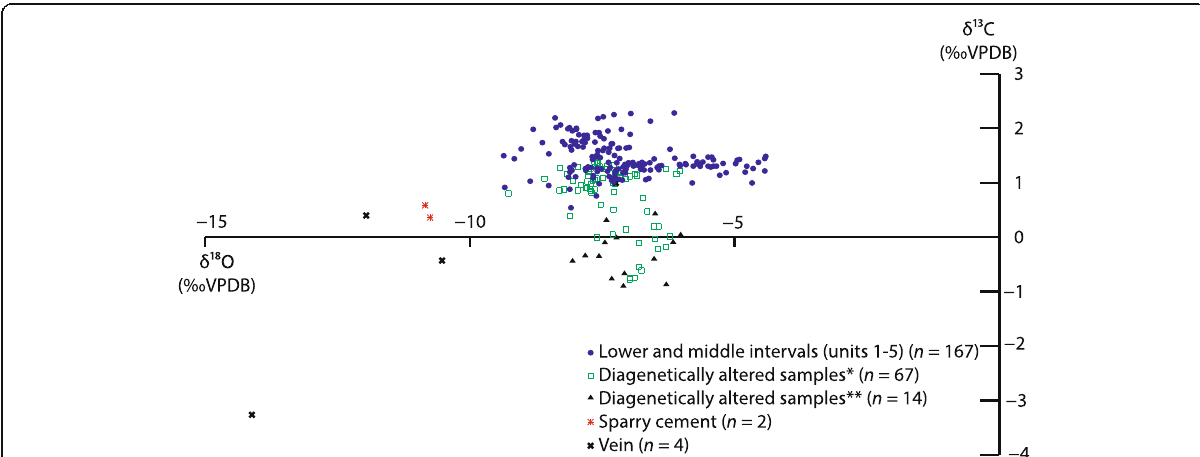
Fig. 7 Cross-plots displaying the relationship between δ 13 C and δ 18 O values of the studied bulk carbonate samples. Vein samples are from 1.14 – 1.20, 3.29 – 3.33, 120.39 – 120.43, and 148.68 – 148.72 mdfrh in core no. 4. Cement samples are from 82.28 – 82.32 and 136.33 – 136.39 mdfrh in core no. 4. *Samples identified as diagenetically altered based on trace element (Mn and Sr) criteria. **Samples that passed the geochemical screening for diagenetic alteration but were identified as altered based on petrographic observations (shown in gray in Fig.